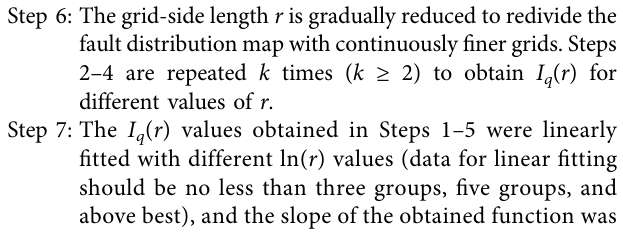
Frontiers in Earth Science |